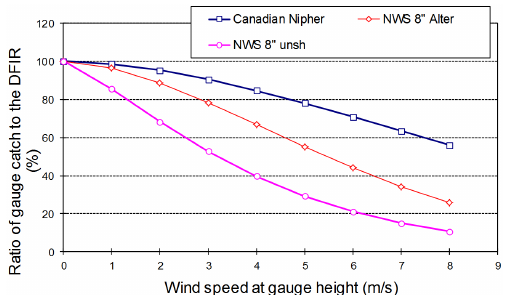
Figure 3. Monthly precipitation records at the Barter station dur- ing 1978–1988. The months with more than 50mm (black line) are labelled.